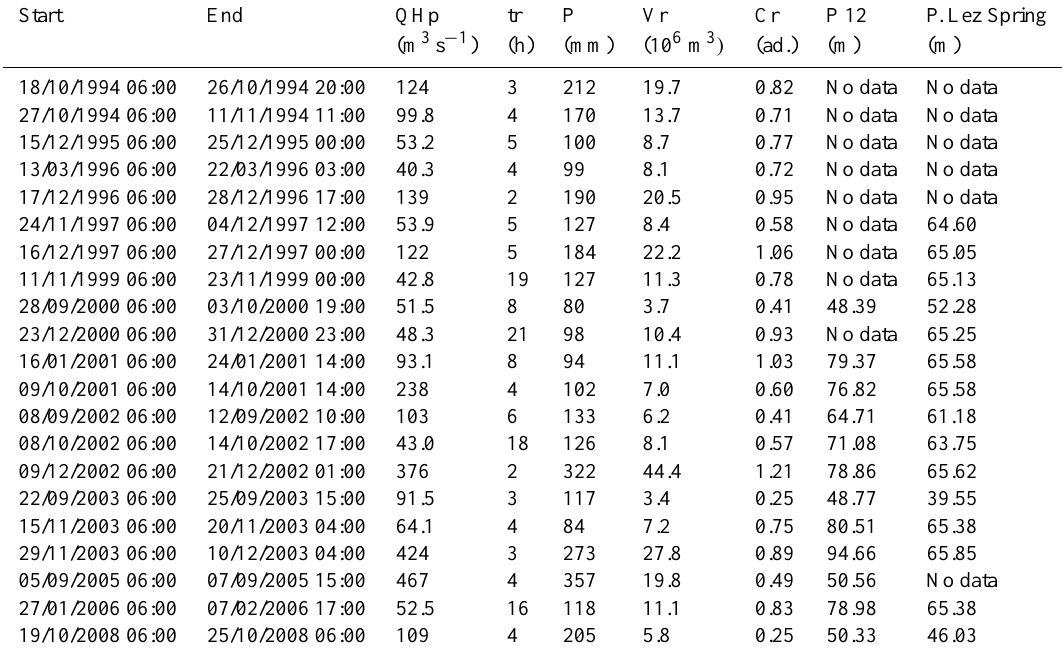
Table 1. Characteristics of the events: QHp hourly peak flow, tr lag-time (elapsed time between the maximal hourly peak flow and the maximal hourly rainfall intensity), P mean areal storm depth derived from Thiessen method, Vr runoff volume, Cr runoff coefficient,